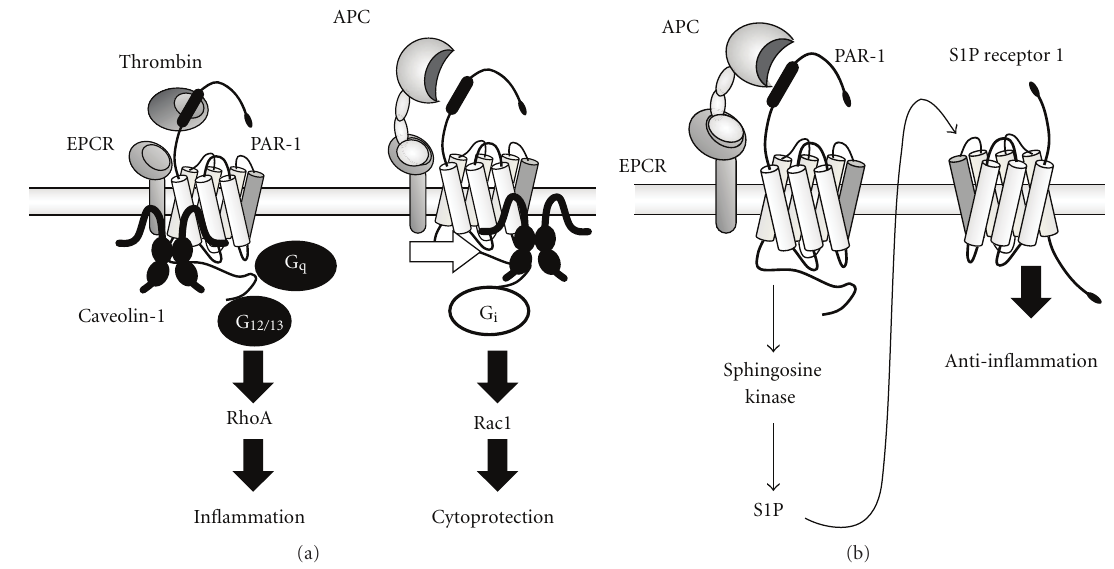
Figure 4: Potential molecular mechanisms by which APC executes anti-inflammatory e ff ects. (a) Caveolin-1 is associated with EPCR in lipid rafts in the absence of protein C or APC. Thrombin cleavage of PAR-1 induces inflammatory responses by coupling receptors to G12/13 and Gq proteins. The occupancy of EPCR by protein C results in the dissociation of EPCR from caveolin-1. Thrombin induces a cytoprotective response by coupling receptors to Gi protein. (b) The APC-EPCR complex cleavage of PAR-1 induces S1P generation and S1P receptor 1 transactivation. Activation of S1P receptor 1 improves endothelial barrier function, thus facilitating the ability of the APC-EPCR complex to exert anti-inflammatory e ff